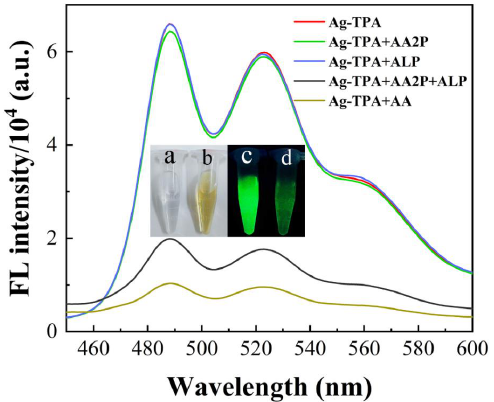
Figure 4. Fluorescent spectra of the Ag-TPA CPN solution (red line) in the presence of AA2P (green line), ALP (blue line), and AA (brown line), and the coexistence of ALP and AA2P (black line), respectively. Inset: Photos of fluorescent Ag-TPA CPNs in the absence ( a , c ) and presence ( b , d ) of ALP under daylight (left) and a 302 nm UV lamp (right): c (ALP): 10 mU/mL; c (AA2P): 0.25 mM; c (AA): 0.25 mM; Ag-TPA CPN solution: 50 μ L; λ ex : 320 nm.